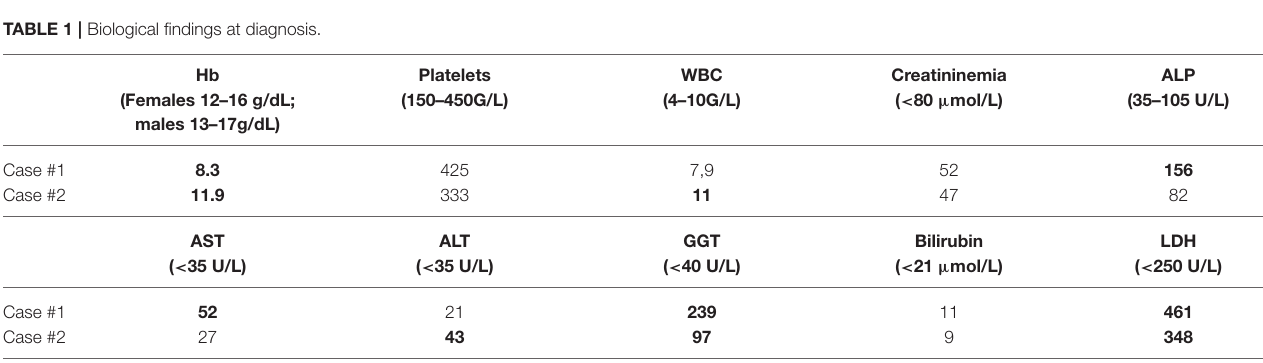
TABLE 1 | Biological findings at diagnosis.